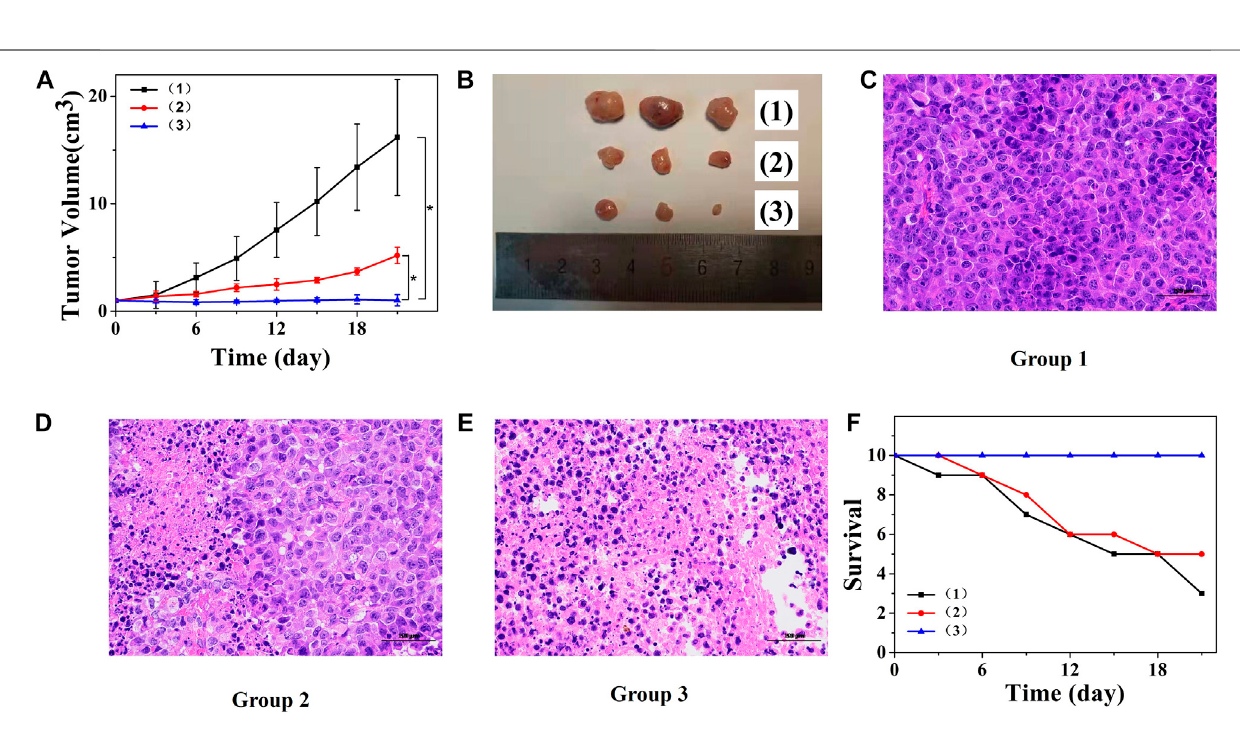
FIGURE 6 | (A) Changes in tumor volumes of mice receiving different treatments. * p < 0.01. (B) Tumor images after treatment and observation period. (C) Pathological section of tumor tissue from group 1 via H&E staining. (D) Pathological section of tumor tissue from group 2 via H&E staining. (E) Pathological section of tumor tissue from group 3 via H&E staining. Scale bars: 100 μ m. (F) Survival curves of mice in each group ( n (cid:1) 10 each group). Each mouse was intravenously injected with saline solution (100 μ l) (1), PTX@PPD NPs (100 μ l, 0.5 mg/ml) (2), and PTX@PSA NPs (100 μ l, 0.5 mg/ml)